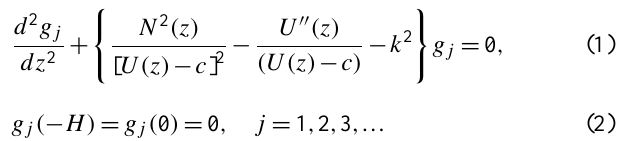
and by the end of the tidal cycle it completely separates from the tail.